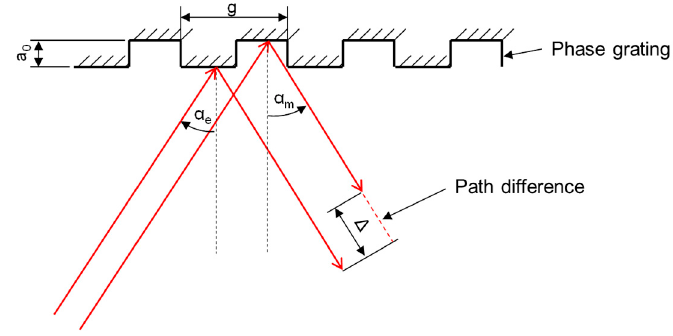
Figure 3. Diffraction of light by a reflective phase grating.